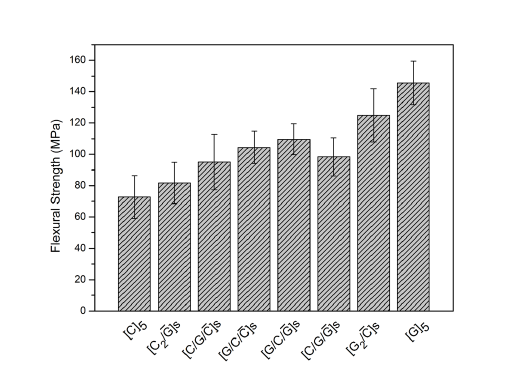
Figure 3. Impact strength of the studied laminates.